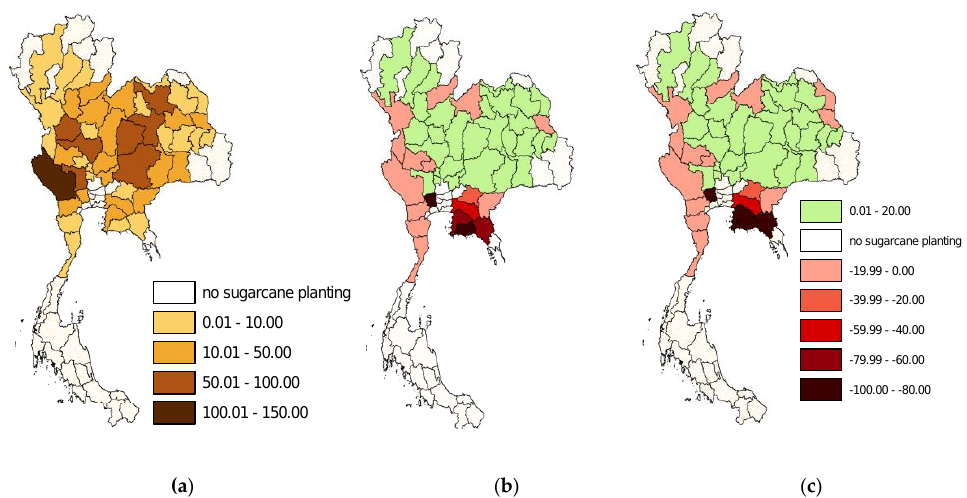
Figure 5. Projected percent changes in harvested area of sugarcane under climate change scenarios. ( a ) Baseline harvested area (1000 ha); ( b ) percent of change in harvested area under RCP4.5; ( c ) percent of change in harvested area under RCP8.5.